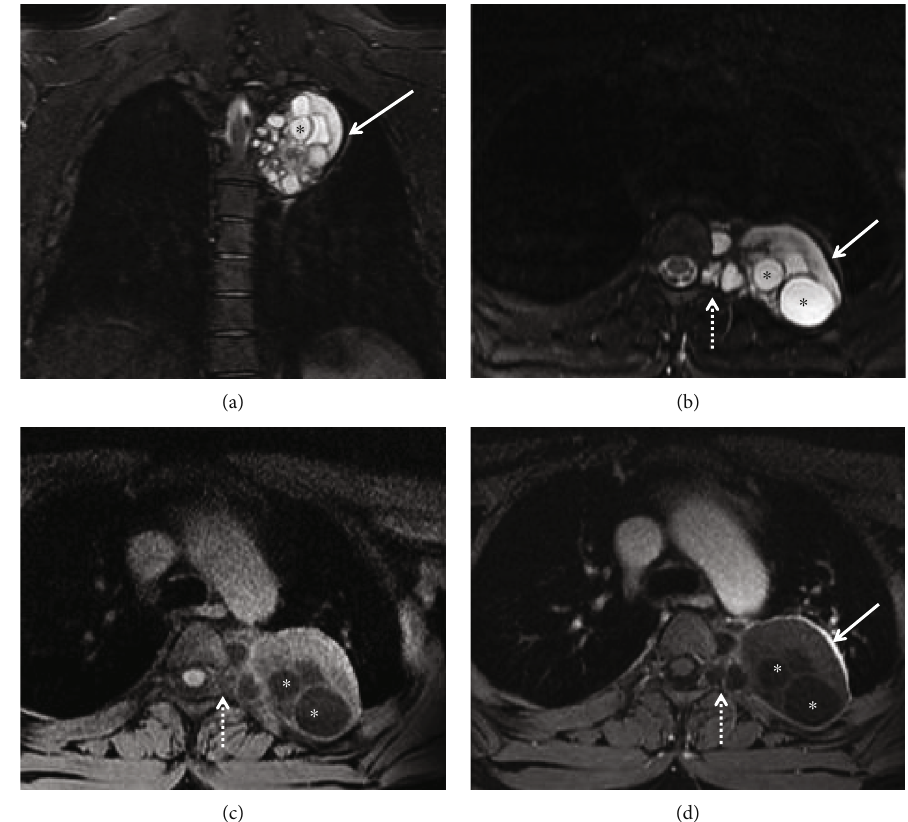
Figure 3: Coronal (a) and axial (b) T2-weighted images and axial T1-weighted images pre- (c) and post-IV contrast injection (d) show a left paravertebral hydatid cyst. The cystic mass shows numerous and variable in size daughter cysts (asterisks), the rim of low signal intensity on T2-weight images with enhancement in the postcontrast image (arrows), and extension into the adjacent neural foramina (dashed